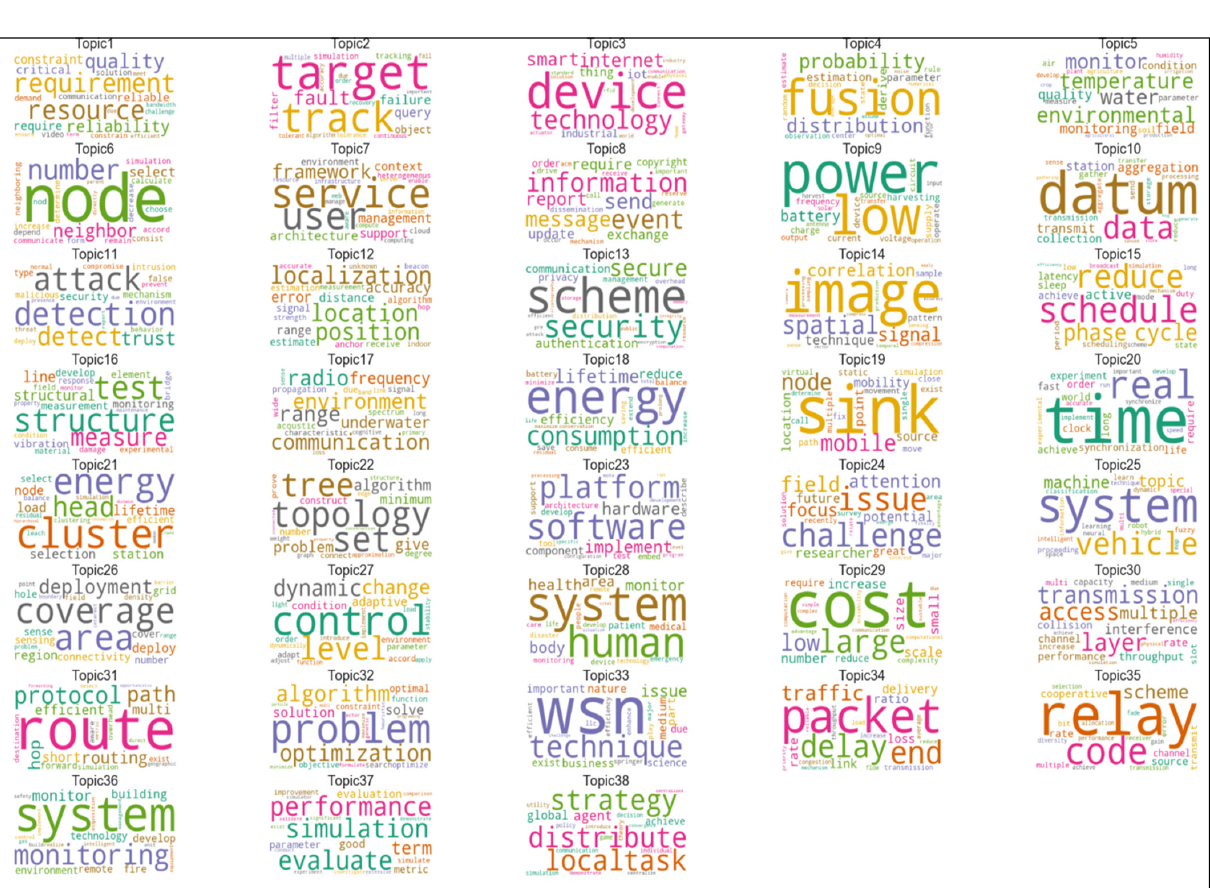
Figure 5. Word-Cloud in documents of wireless sensor networks.